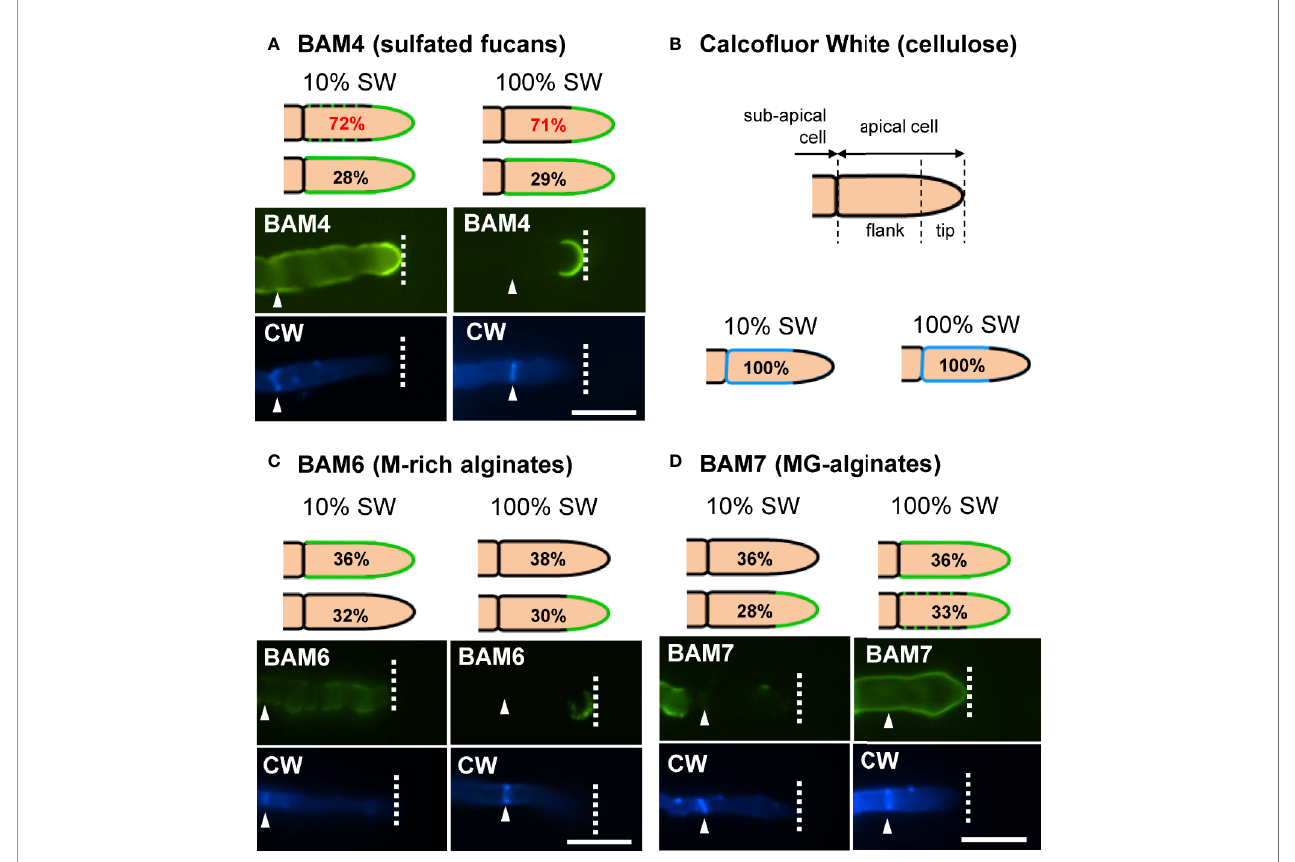
FIGURE 5 | Immuno fl uorescence detection of fucan and alginate epitopes in E. subulatus apical cells. The schematic representations indicating the percentages of the BAM-immuno fl uorescence distribution in apical cells observed in 10% ASW and 100% ASW are shown together with representative pictures featuring labeling. Detections by the BAM antibodies (green fl uorescence) and Calco fl uor White (blue fl uorescence) are shown. The dotted lines in the schematic representations indicates occasional labeling. The dotted line on the micrographs indicates the distal limit of the apical cell. (A) The BAM4 binding was preferentially located at the tip in either 10% or 100% ASW, but detection was also frequently observed at the fl anks in 10% ASW but not in 100% ASW. The tip was always labeled by the BAM4 antibody. (B) Cellulose was detected by Calco fl uor White in all walls except at the tip. Alginates epitopes as detected by the BAM6 (C) and the BAM7 (D) antibodies showed a greater variety of locations in apical cell walls than BAM4-fucans. n ≥ 33 for each culture condition and labeling type. Scale bar = 20